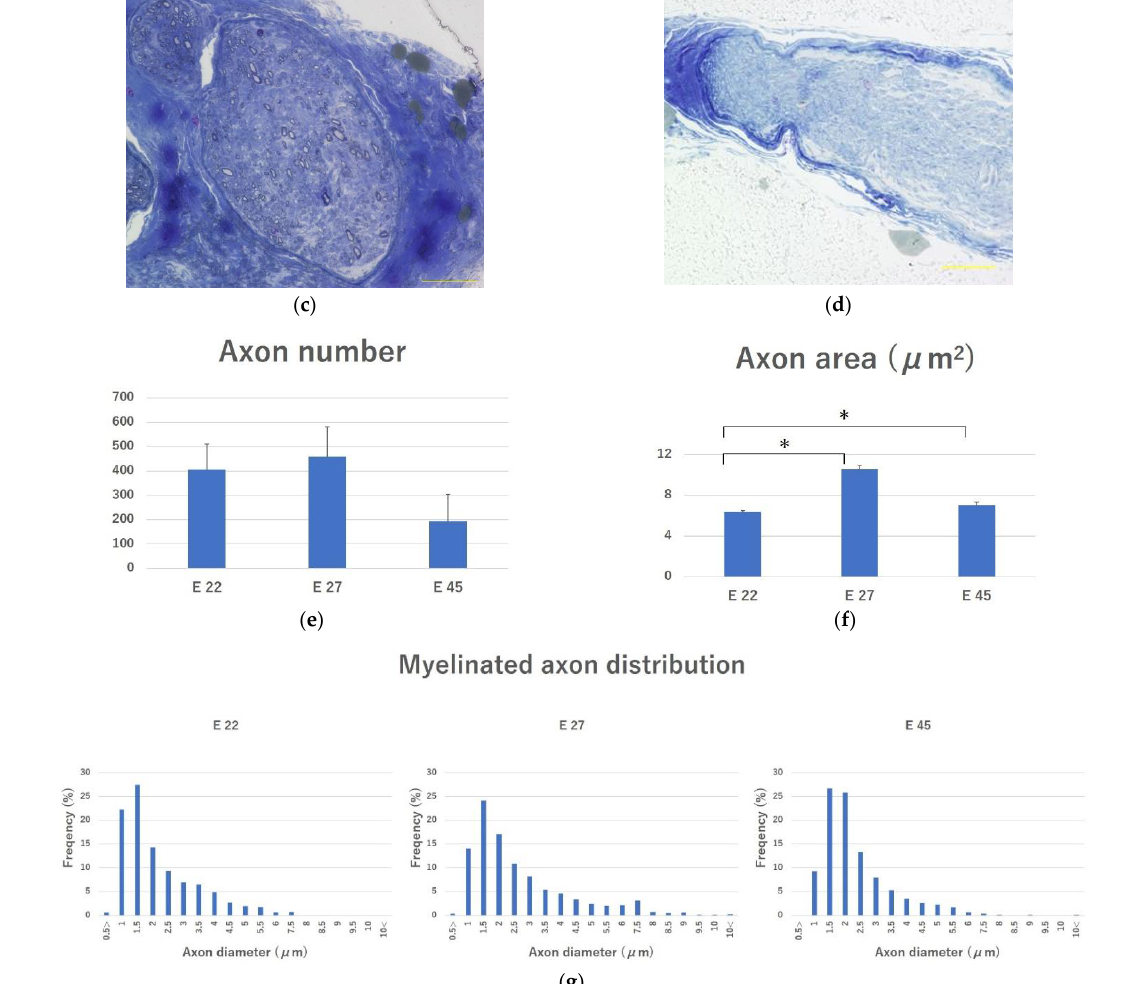
Figure 7. Evaluation of regenerated myelinated axons in the peroneal nerve. ( a ) Microscopic image of the peroneal nerve in the E 22, ( b ) E 27, ( c ) E 45, and ( d ) surgical control group after toluidine blue staining. ( e ) Axon number and ( f ) cross-sectional area of the myelinated axons were compared. ( g ) Distribution of myelinated axon diameter in each group (percentage of fibers (%) for each fiber diameter category). Scale bar = 50 µm. * p < 0.05 between groups. The data are presented as mean ± SE.